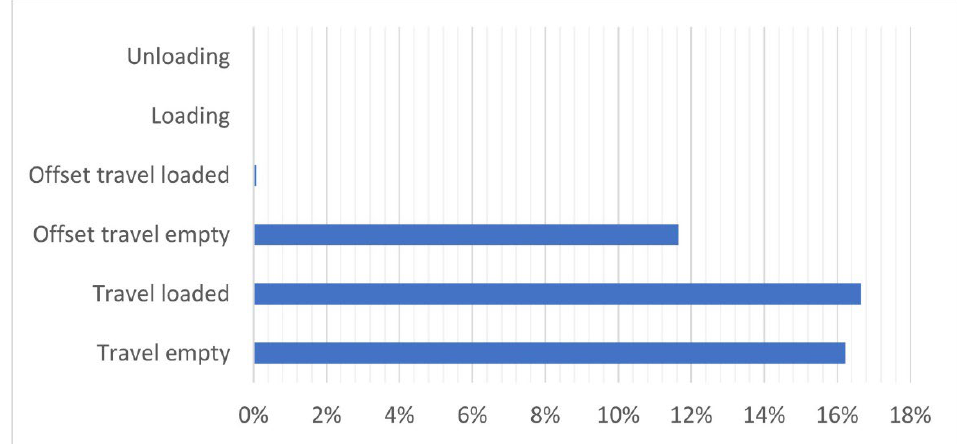
Figure 7. Energy savings in the inbound docking operations .